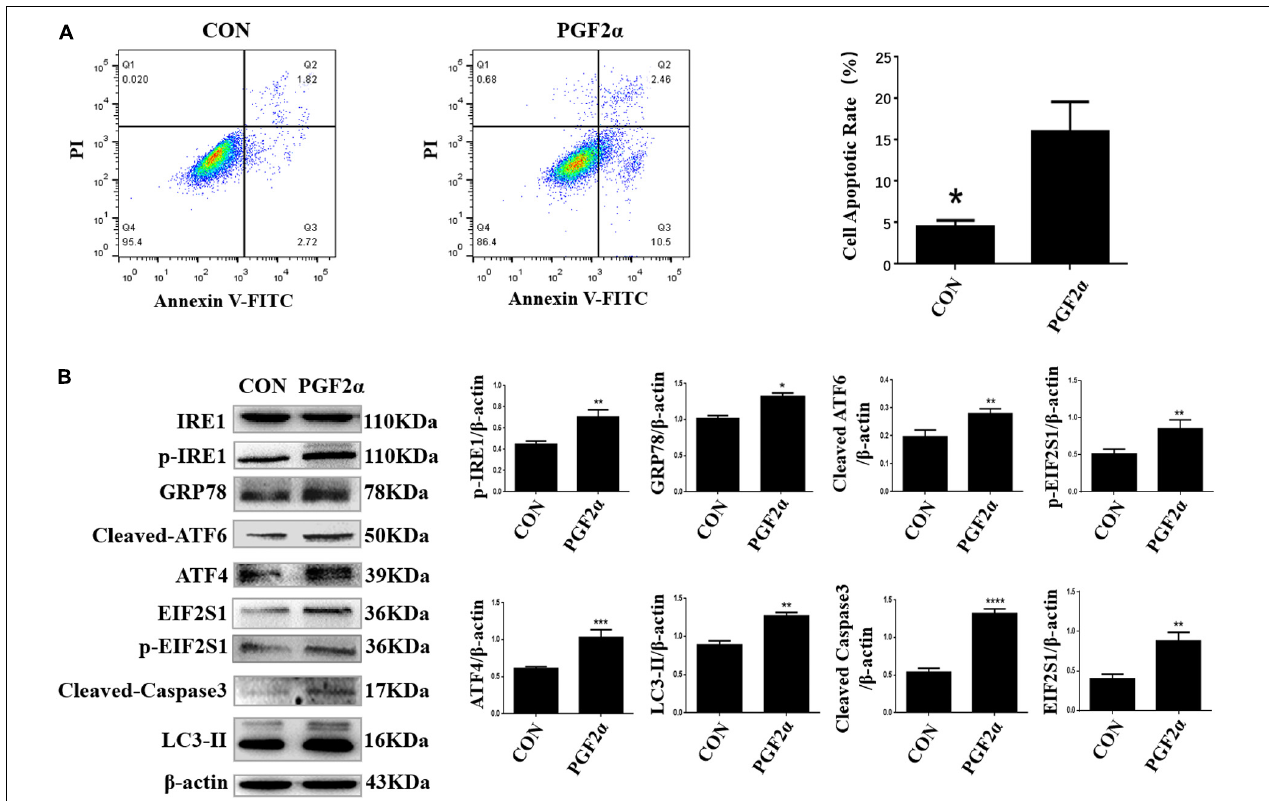
FIGURE 2 | PGF2 α induces ER stress, autophagy, and apoptosis in goat luteal cells. (A) Cells cultured in medium with PGF2 α (1 µ M) or isopycnic PBS for 24 h are stained with Annexin V-FITC/PI and analyzed by flow cytometry. B: Cells are treated with PBS or PGF2 α for 24 h. The expression of IRE1, GRP78, ATF6, ATF4, and LC3 are detected by western blot analysis. The histogram shows relative protein expression displayed in (B) from three separate experiments. Data in the bar graph represent the means ± SEM of three independent experiments ( N = 3). Means are compared with one-way ANOVA combined with Tukey’s post hoc tests. * p < 0.05, ** p < 0.01, *** p < 0.001, **** p < 0.0001 compared to